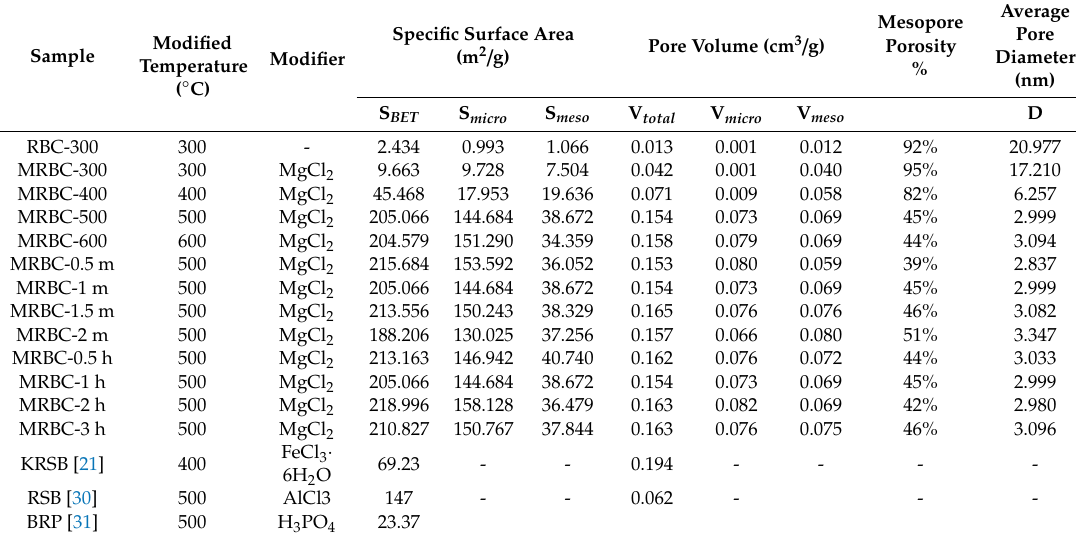
Table 3. Pore structure parameters of MRBCs and